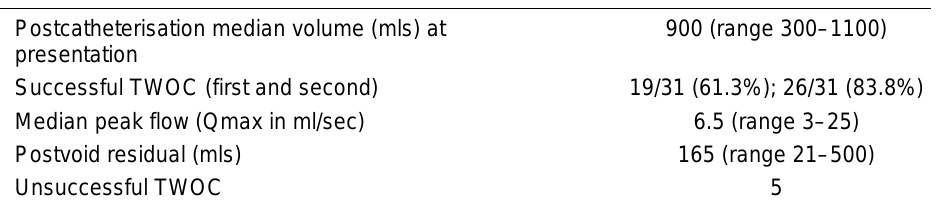
Immediate Outcome of